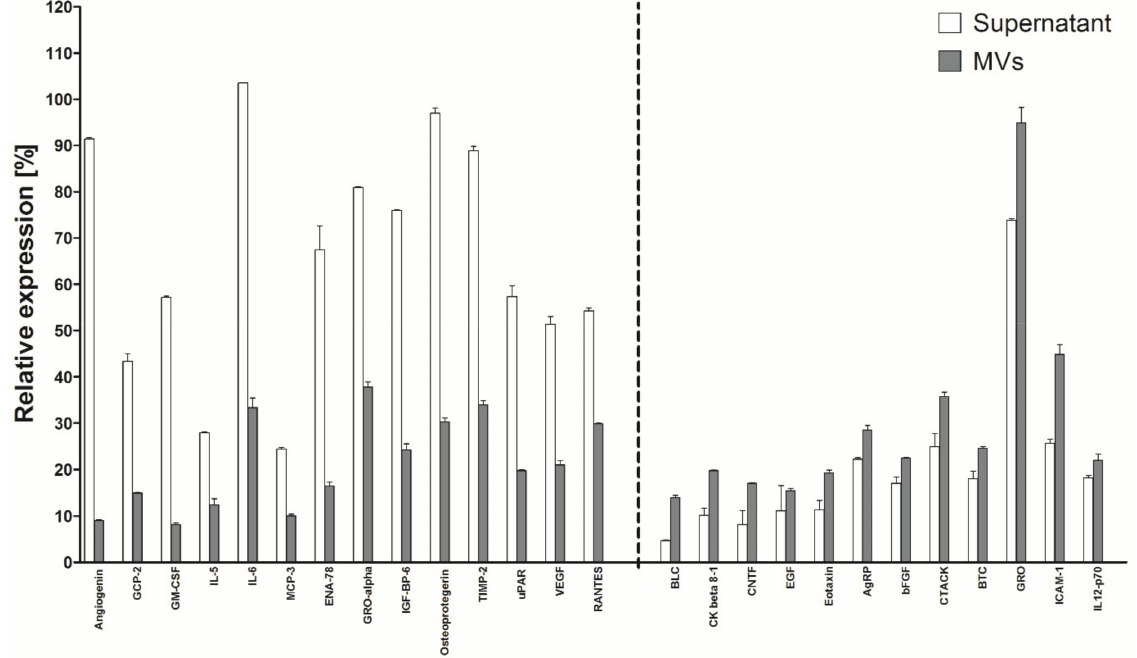
Figure 11. Selected cytokine production in the free form (Supernatant) and in the microvesicles (MVs) form. The secretory profile of the tested line was determined using the RayBio C-series Human Cytokine Antibody Array for a panel of 120 cytokines and expressed as a histogram relative to a positive control. The MVs present in the supernatant were obtained by sequential centrifugations. They were lysed 100% to evaluate cytokine concentration. The data represent the mean from a duplicate assessment ±